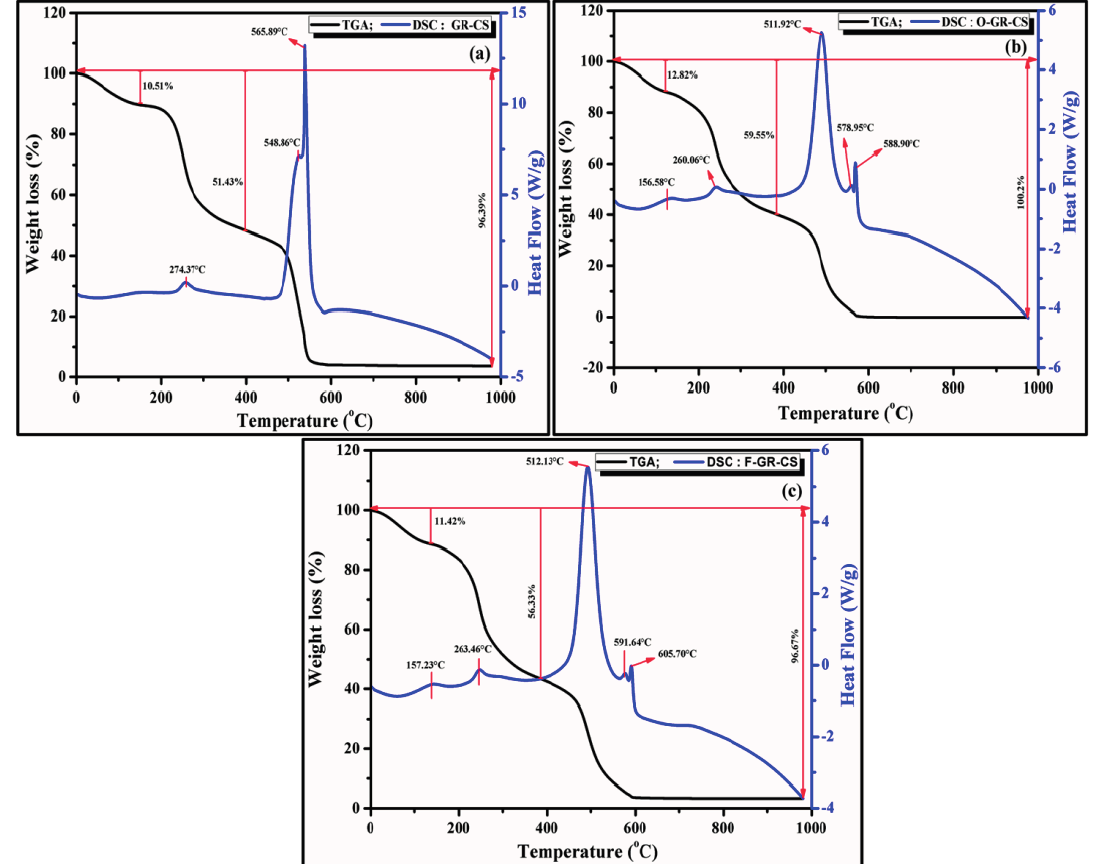
Figure 9. Thermographs of GR/CS, o-GR/CS and f-GR/CS composite